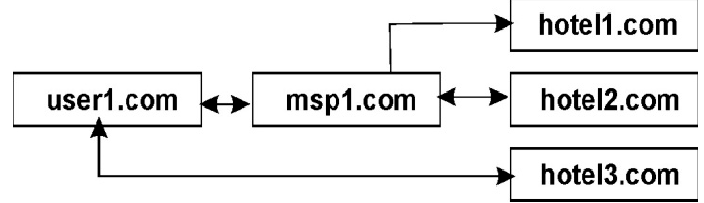
Figure 8. Hybrid Data Mashup for Lodging Services.